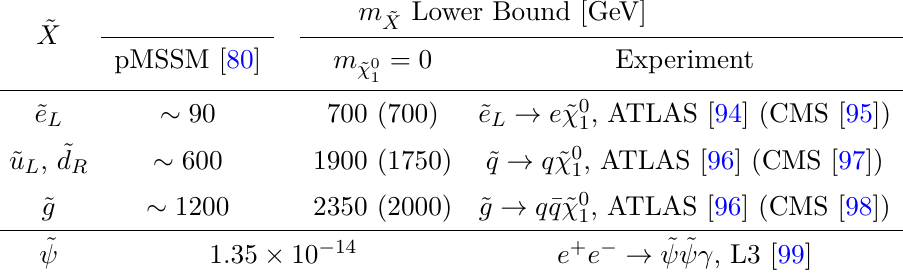
JHEP03(2022)152